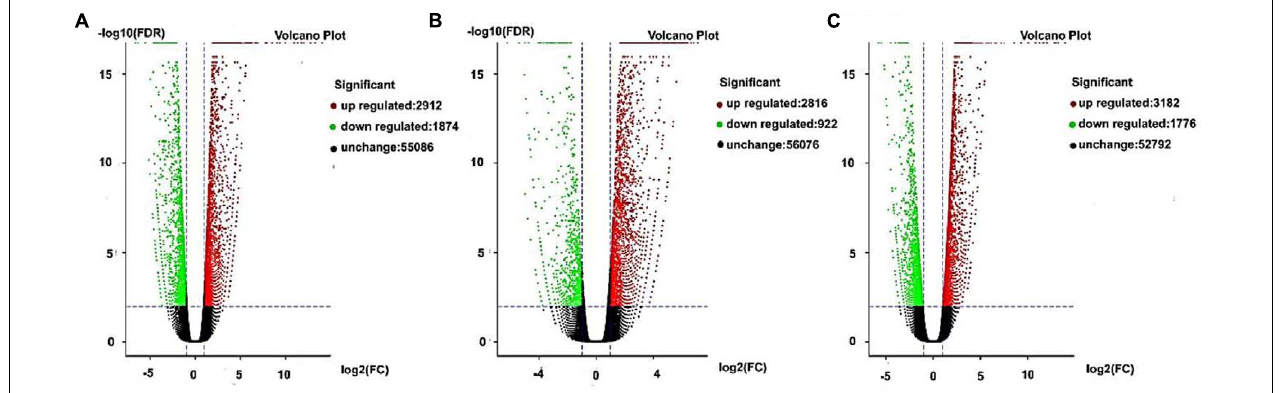
FIGURE 5 | Differentially expressed genes as volcano plots. (A–C) Represent the expression levels of every gene in AF relative to AS during the later uninucleate, binucleate, and trinucleate stages, respectively. Every DEG point in the volcano plot represents one gene. The horizontal axis represents the difference in the specific gene expression levels in the two samples as a numerical value (ratio). The vertical axis shows the false discovery rate as negative values. When the absolute value of abscissa is higher, the relative difference in expression is greater between the two samples. A higher ordinate value indicates a more significant difference in expression, and thus the more reliable screening of DEGs. Green dots represent downregulated genes, red dots are upregulated genes, and black dots indicate no difference in the expression level in AF and